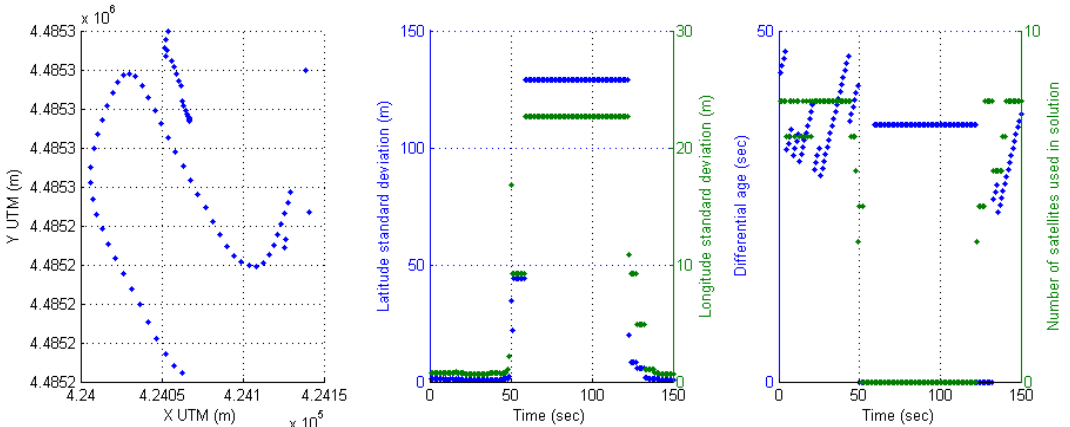
Figure 17. Non-underground parking area with zero satellite visibility and inactive DGPS mode using a constant